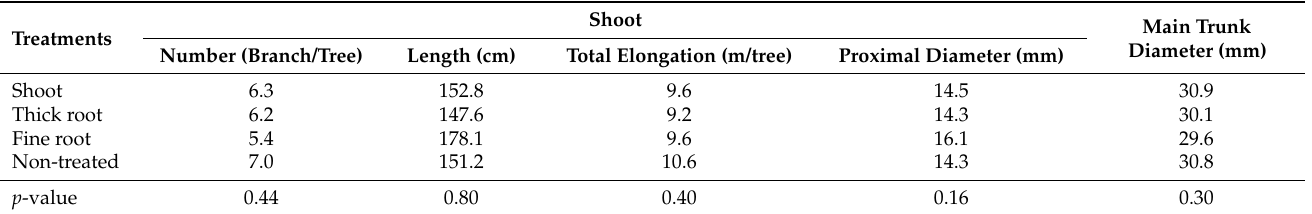
Table 3. The growth of Japanese pear trees in soil mixed with shoots and roots of Japanese pear trees.